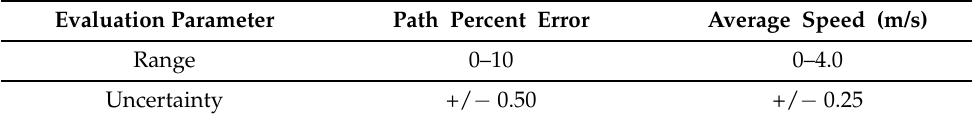
Table 6. Range of values for construction of Case Study III MFs.